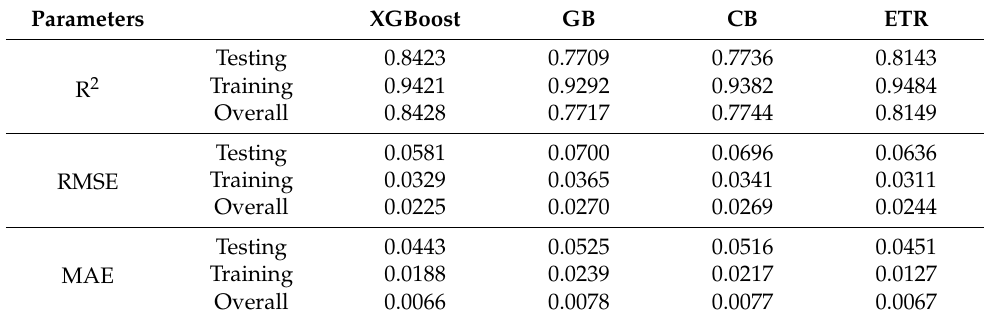
Table 5. Performance of XB Boost, GB, CB, and ETR with different parameters.